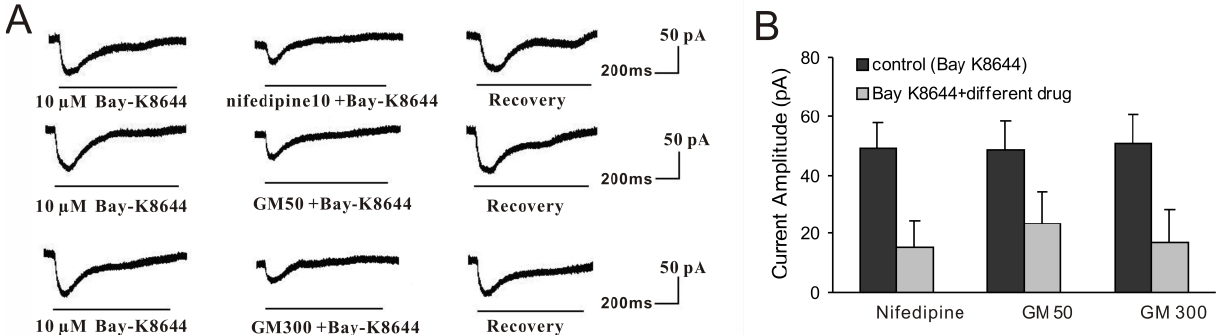
Figure 7. Effect of GM on (-)-Bay-K8644-activated current (HP = −50 mV). ( A )